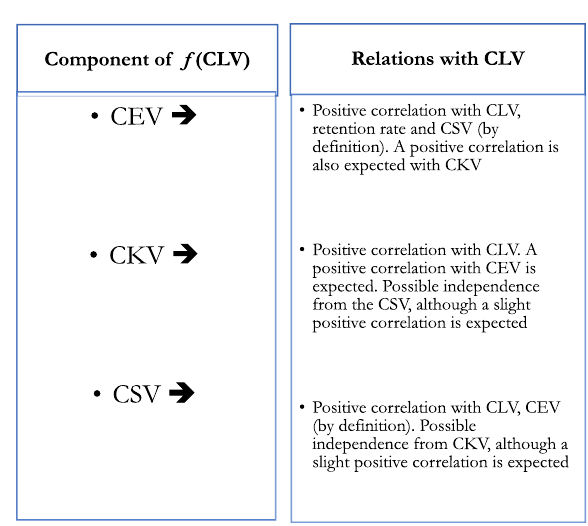
Fig. 2 Table with the relations of the ƒ (CLV) and its components. The correlation between the constructs allows us to carry out a fi rst analysis that will later be